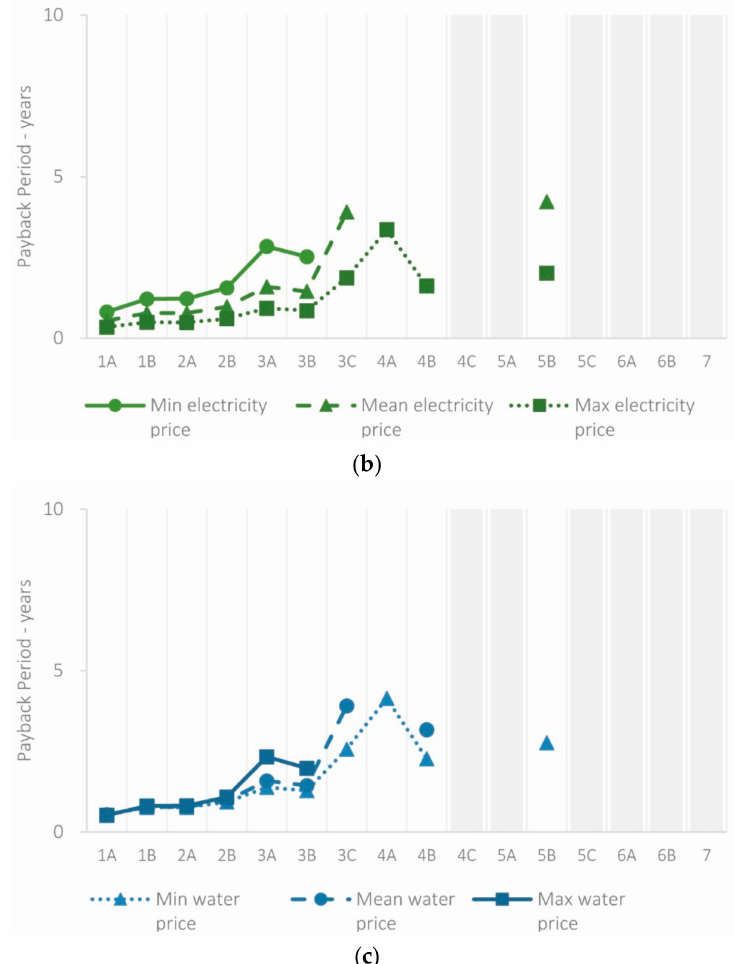
Figure 11. Payback times of ABS cooling solutions with respect to FC solutions depending on electricity and water prices ( a ) FC with DC, sensitivity to electricity price; ( b ) FC with CT, sensitivity to electricity price; ( c ) FC with CT, sensitivity to water